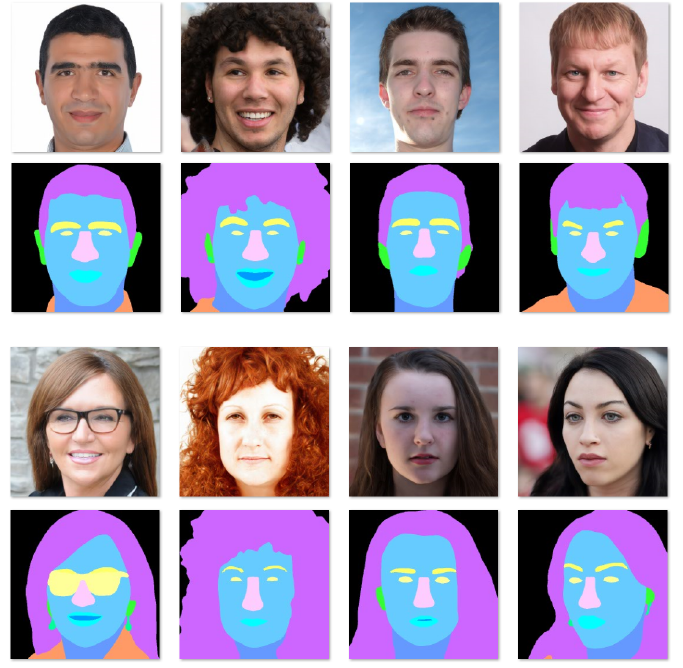
Figure 2. Mask segmentation